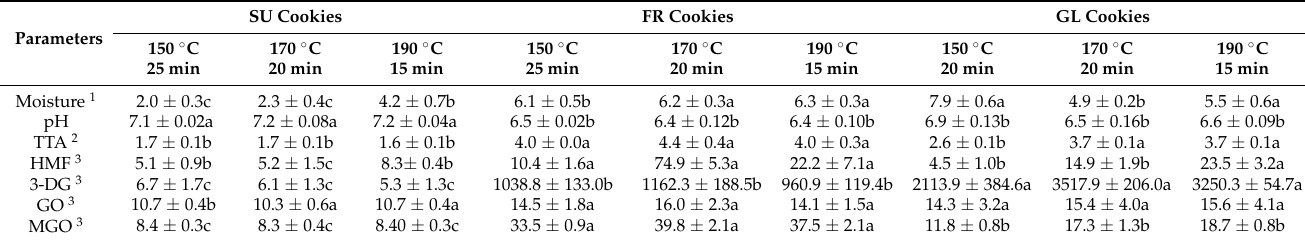
Table 2. Chemical parameters of cookie samples as a function of the type of sugar, baking time, and temperature. SU Parameters